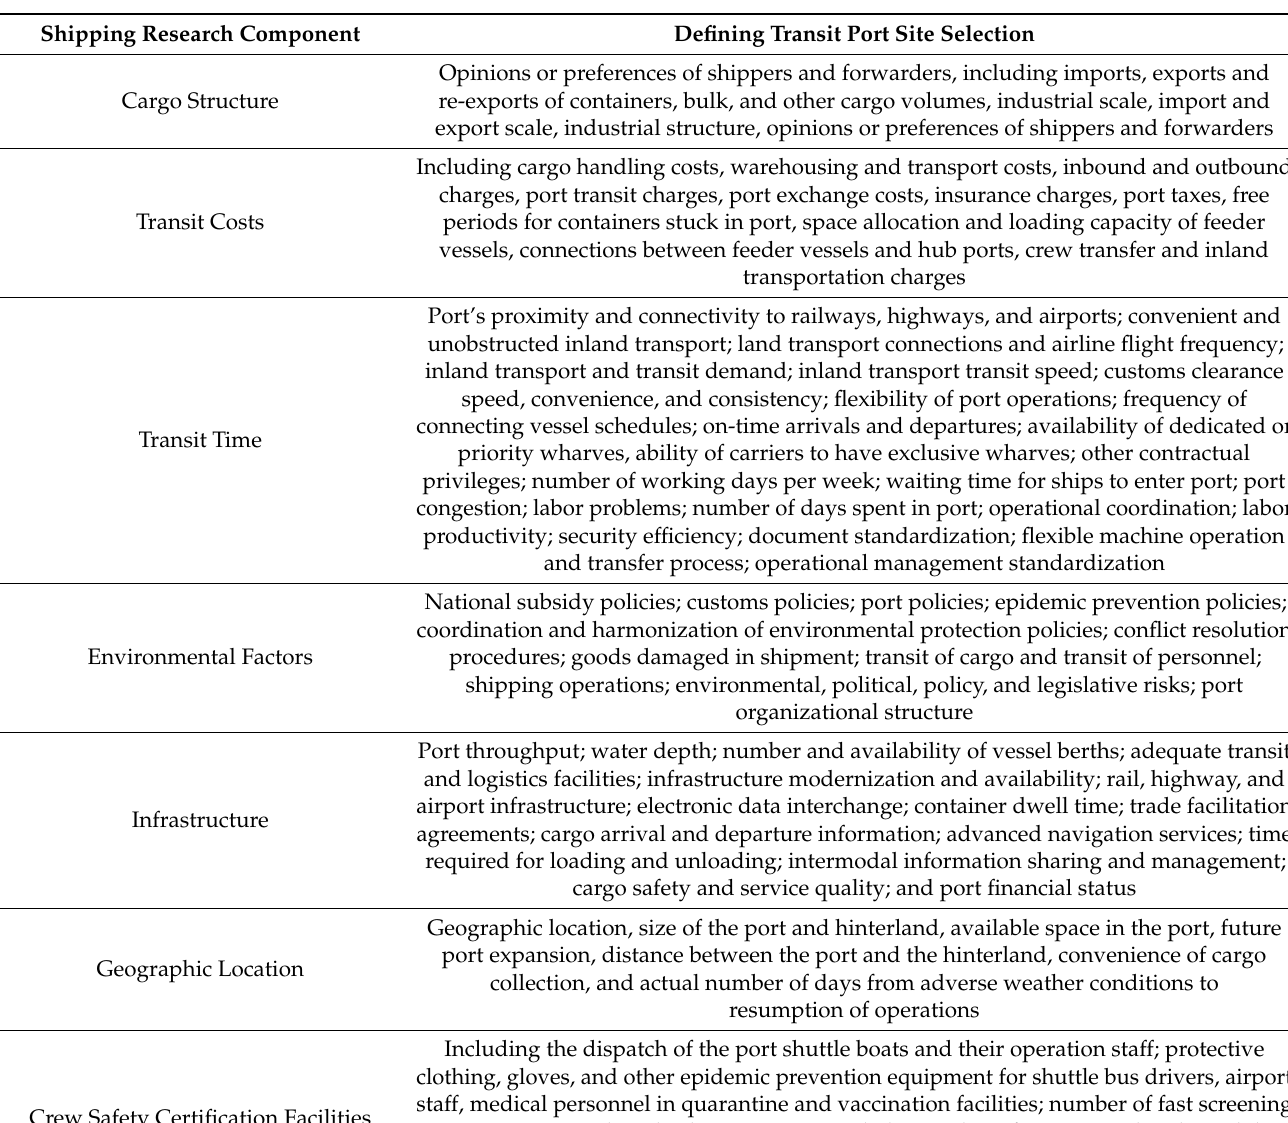
Table 1. Definition and evaluation criteria of the best alternatives for developing international crew-change transit centers in Taiwanese ports.